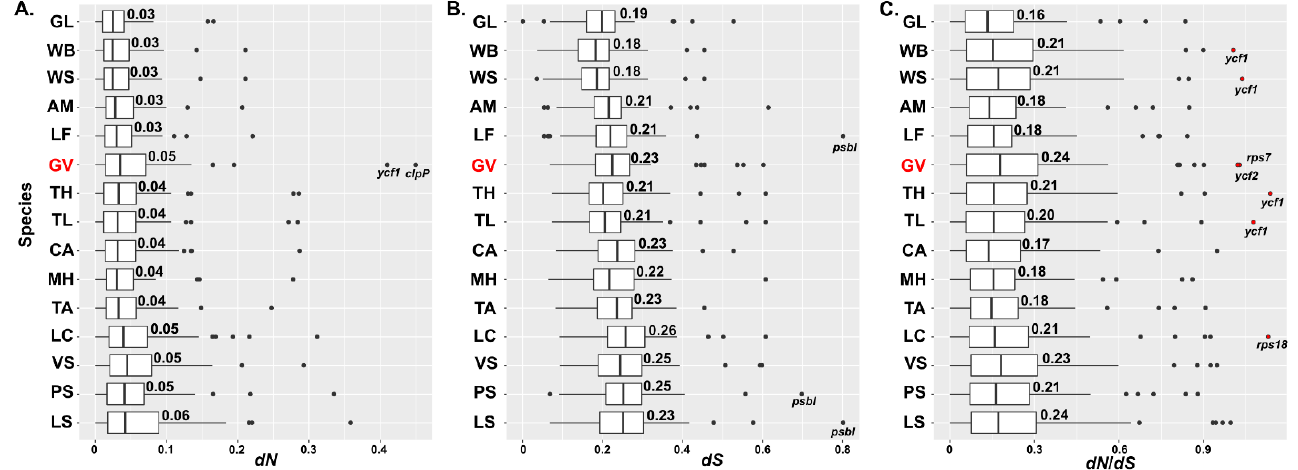
Figure 5. Boxplot showing the variation in non-synonymous substitutions ( dN ) ( A ), synonymous substitutions ( dS ) ( B ), and dN / dS ( C ) for the IRLC species. The median values are indicated above the whiskers. The red circles ( C ) show the genes of IRLC species with dN / dS > 1. LJ, Lotus japonicus ; GL, Glycyrrhiza lepidota ; WB, Wisteria brachybotrys ; WS, Wisteria sinensis ; AM, Astragalus mongholicus var. nakainus ; LF, Lessertia frutescens ; GV, Gueldenstaetia verna ; TH, Tibetia himalacia ; TL, Tibetia liangsharensis ; CA, Cicer arietinum ; MH, Medicago hybrida ; TA, Trifolium aureum ; LS, Lens culinaris ; VS, Vicia sativa ; PS, Pisum sativum ; LS, Lathyrus sativus .